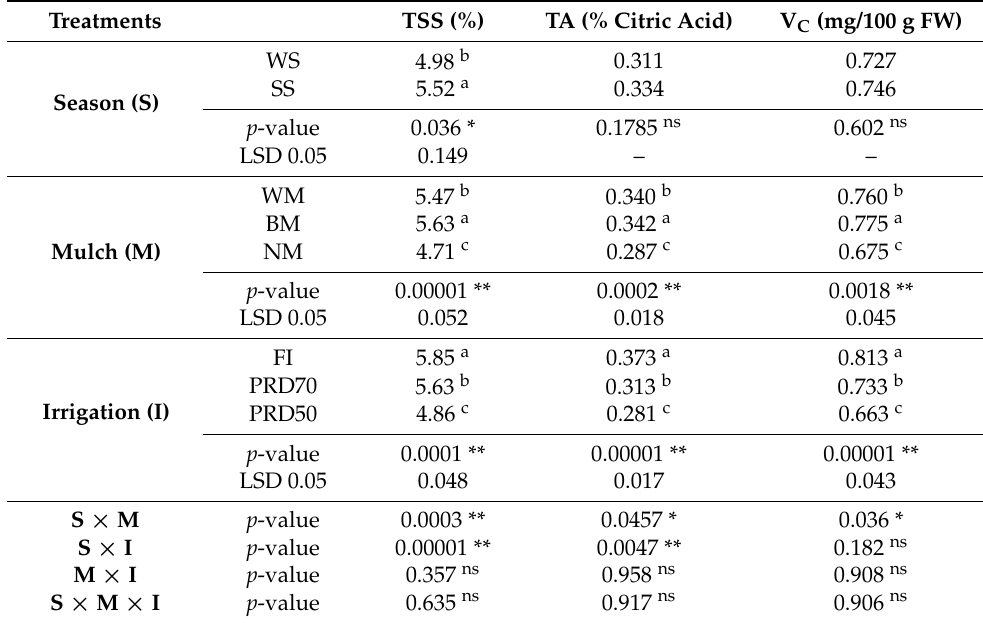
Table 4. Analysis of variance of squash fruit quality, total soluble solids (TSS), total acidity (TA), and vitamin C (V C ) for winter and spring growing seasons.